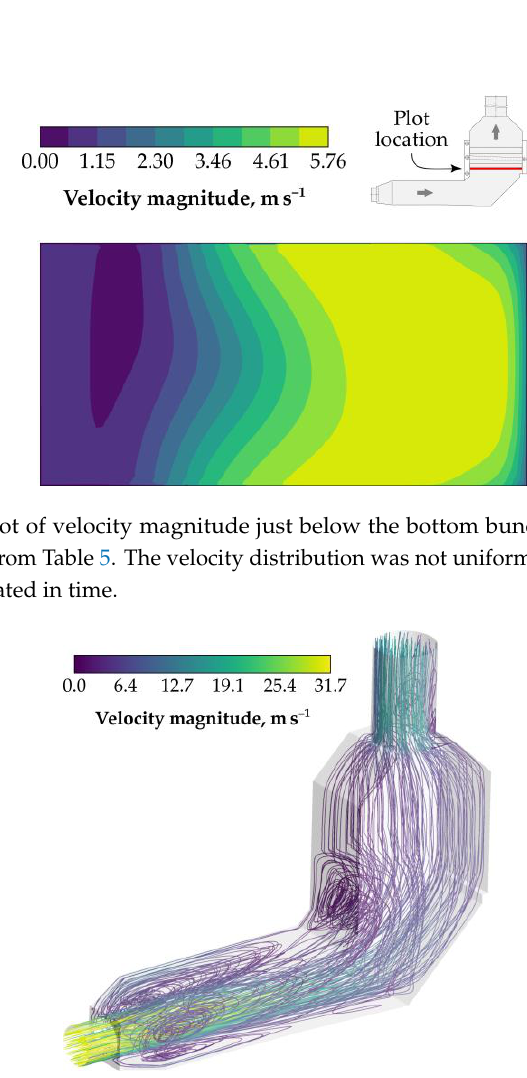
Table 6. Results obtained using the present model and the corresponding errors compared to the data from the operator of the boiler. The accuracy was not as good as in the case of HTRI Xchanger Suite, but, in terms of fast, approximate analyses of process and power equipment, it was sufficient.